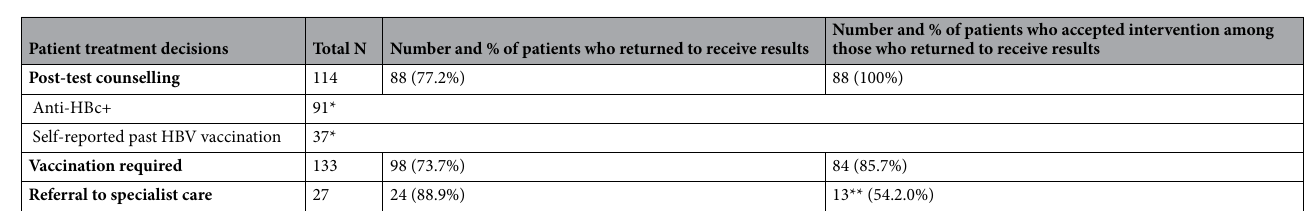
Table 2. Patient treatment decisions and cascade of care proportions. *14 participants reported being previously vaccinated and also were anti-HBc positive. **16 accepted the direct referral to one of the two hospitals linked to the project, of which 12 had a documented first visit with a specialist. Eight participants preferred visiting their own physicians (not the hospitals included in the study) due to distance and transportation issues, of which one had a documented first